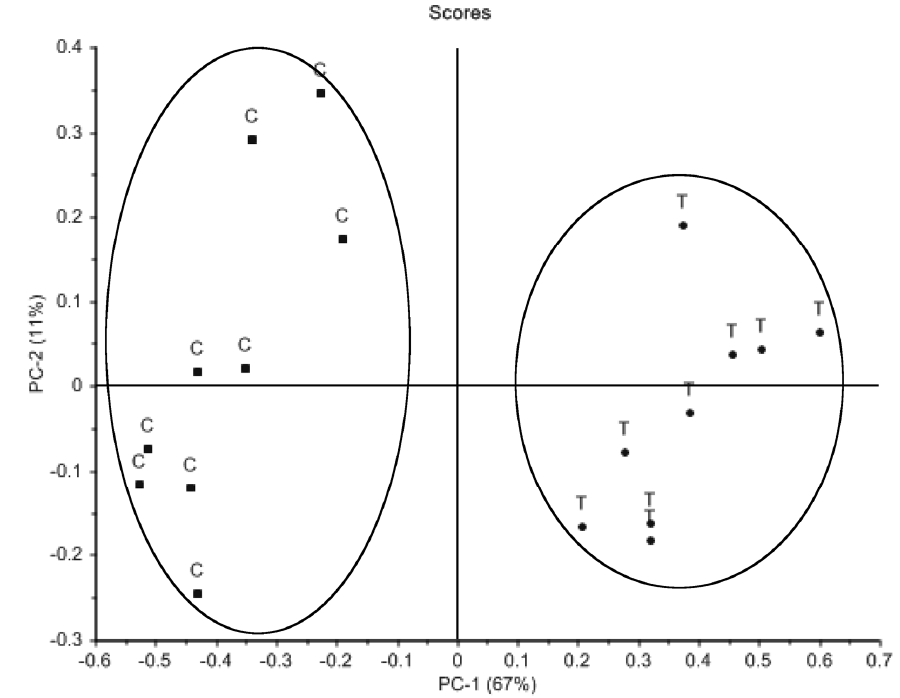
Figure 3. Principal component analysis scores plot of metabolite profiles generated by GC–MS analysis of culture medium (extracellular samples) from rat B50 neuroblastoma cells untreated (C) (n = 9) or treated with 1 mM methamphetamine for 48 h (T) (n = 9).